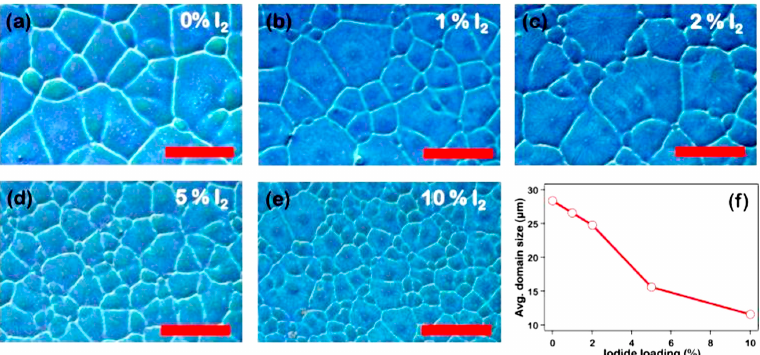
Figure 11. Optical micrographs of hybrid perovskite film (scale bar: 50 μ m) from precursor with ( a ) 0%; ( b ) 1%; ( c ) 2%; ( d ) 5%; and ( e ) 10% iodine solution (40 mM). ( f ) Average domain size as a function of iodide loading during fabrication. The average domain size decreases as the iodide loading increases [96]. Copyright © 2015, American Chemical Society.